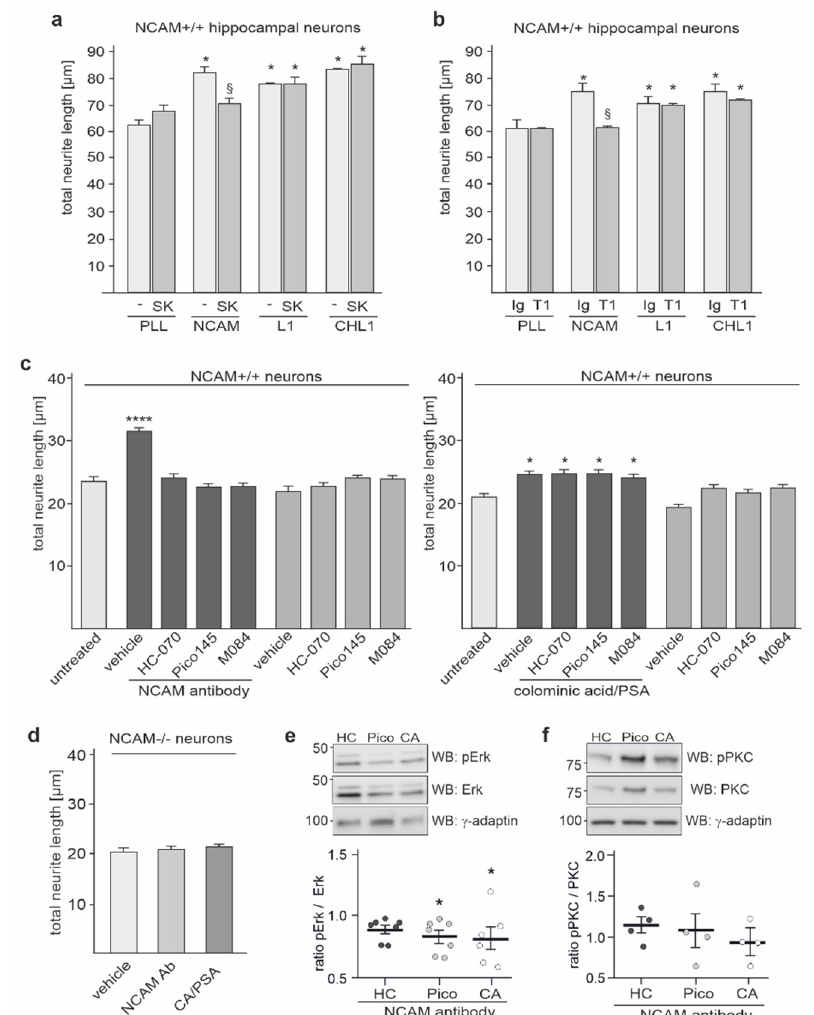
Figure 10. NCAM-mediated signal transduction and neurite outgrowth depend on TRPC1, − 4, and − 5. ( a , b ) Hippocampal neurons were maintained on PLL, NCAM-Fc (NCAM), L1-Fc (L1), or CHL1-Fc (CHL1) and treated without ( − ) ( a ) or with control antibody (Ig) ( b ), TRPC inhibitor SKF96365 ( a ), or function-blocking TRPC1 antibody T1E3 ( b ). Total neurite lengths per neuron were measured to determine neurite outgrowth. Mean values ± SEM from 3 independent experiments with duplicates are shown for neurite outgrowth relative to neurons without additives (* p < 0.01; one-way ANOVA with Dunn’s multiple comparison test) or relative to vehicle control (§ p < 0.01; one-way ANOVA with Dunn´s multiple comparison test). ( c ) Cortical neurons from wild-type (NCAM+/+) ( c ) and NCAM-deficient (NCAM − / − ) ( d ) mice were treated with vehicle alone or together with NCAM antibody (NCAM Ab) or colominic acid/PSA (CA) in the absence ( c , d ) or presence of Pico145 (Pico), HC-070 (HC), or M084 ( c ). Total neurite lengths per neuron were measured to determine neurite outgrowth. Mean values ± SEM from 3 independent experiments with duplicates are shown for neurite outgrowth relative to neurons incubated without additives (* p < 0.05, **** p < 0.0001; one-way ANOVA with Kruskal–Wallis post hoc test). ( e , f ) Wild-type cortical neurons were treated with NCAM antibody in the absence or presence of HC-070 (HC) Pico145 (Pico) or colominic acid/PSA (CA) and subjected to Western blot analysis with antibodies against total and phosphorylated Erk1/2 and PKC and with a γ -adaptin antibody for loading control. Levels of total and phosphorylated Erk1/2 and PKC were determined by Western blot analysis. Mean values ± SEM are shown for the level of phosphorylated Erk1/2 ( e ) and PKC ( f ) relative to total Erk1/2 and PKC levels and relative to the values obtained for NCAM antibody-stimulated neurons in the absence of inhibitors (set to 100%) (* p < 0.05; one-way ANOVA with Kruskal–Wallis post hoc test).